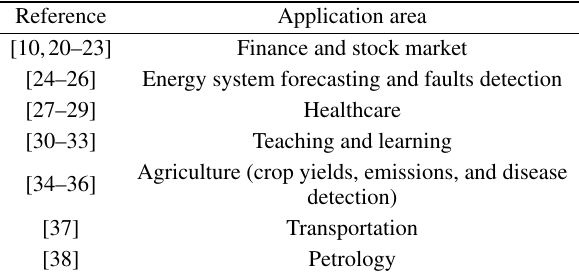
Table 1 Machine learning application in different economic sectors by academicians and industry